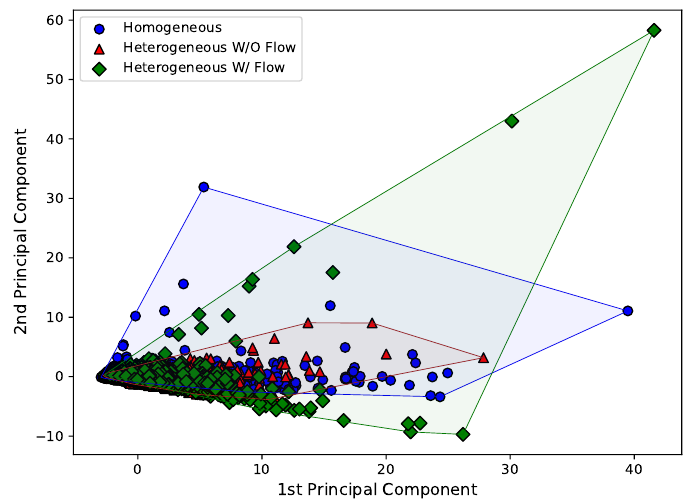
Figure 8. First and second principal components for the activity Hjorth parameter considering all the eight sensors.